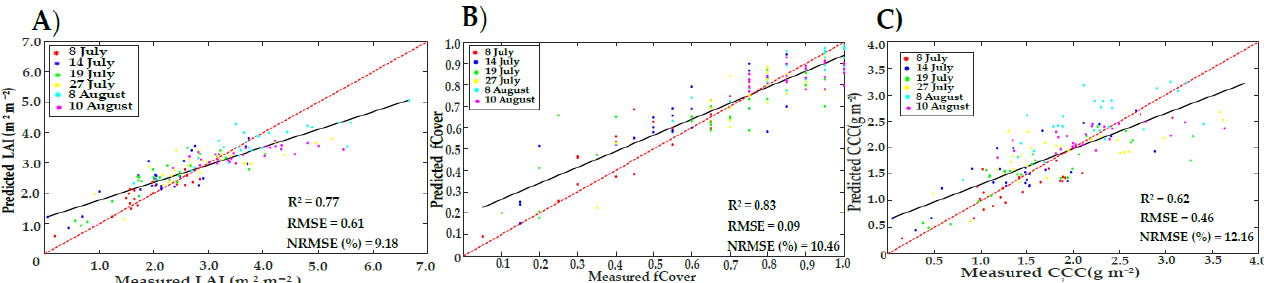
Figure 4. The normalized root mean square error (NRMSE%) obtained from LUTreg and LUTstd in predictions of LAI, fCover, and CCC at three levels of nitrogen.